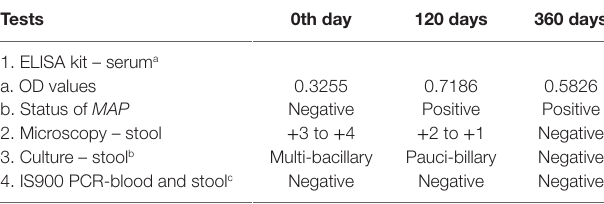
taBLe 2 | screening of clinical samples (feces, blood, and serum) by multiple diagnostic tests for the presence of MAP infection at different days